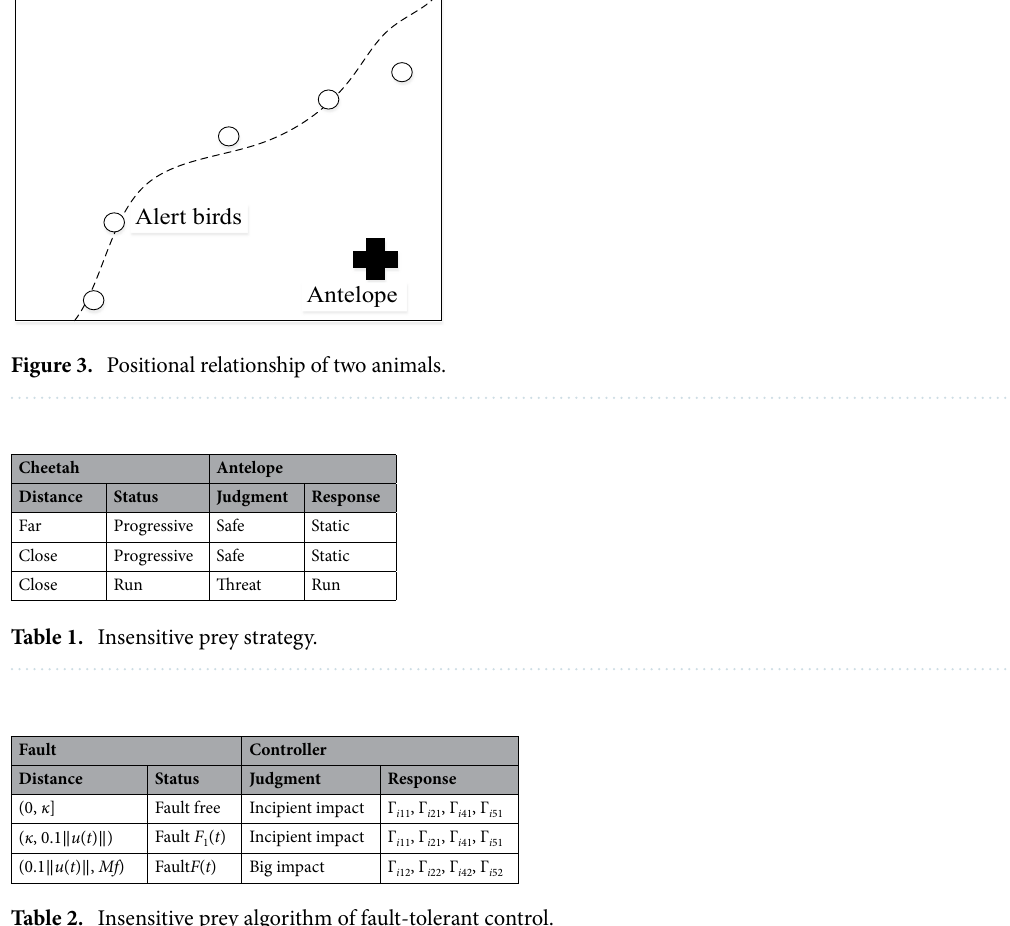
Table 2. Insensitive prey algorithm of fault-tolerant